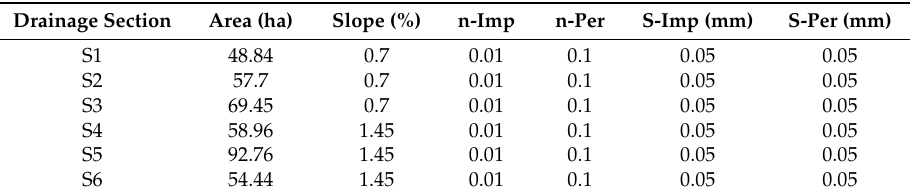
Table 9. Parameters for SWMM.